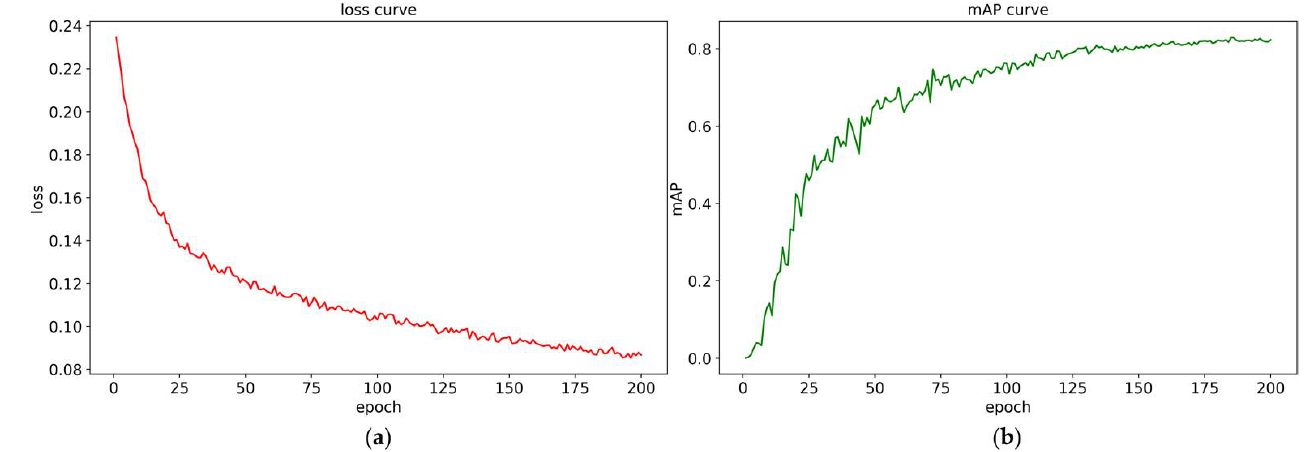
Figure 10. The ( a ) loss curve and ( b ) mAP curve during the training process. 3.2. Comparison Experiment of the Prior Boxes Generated by Different Clustering Methods